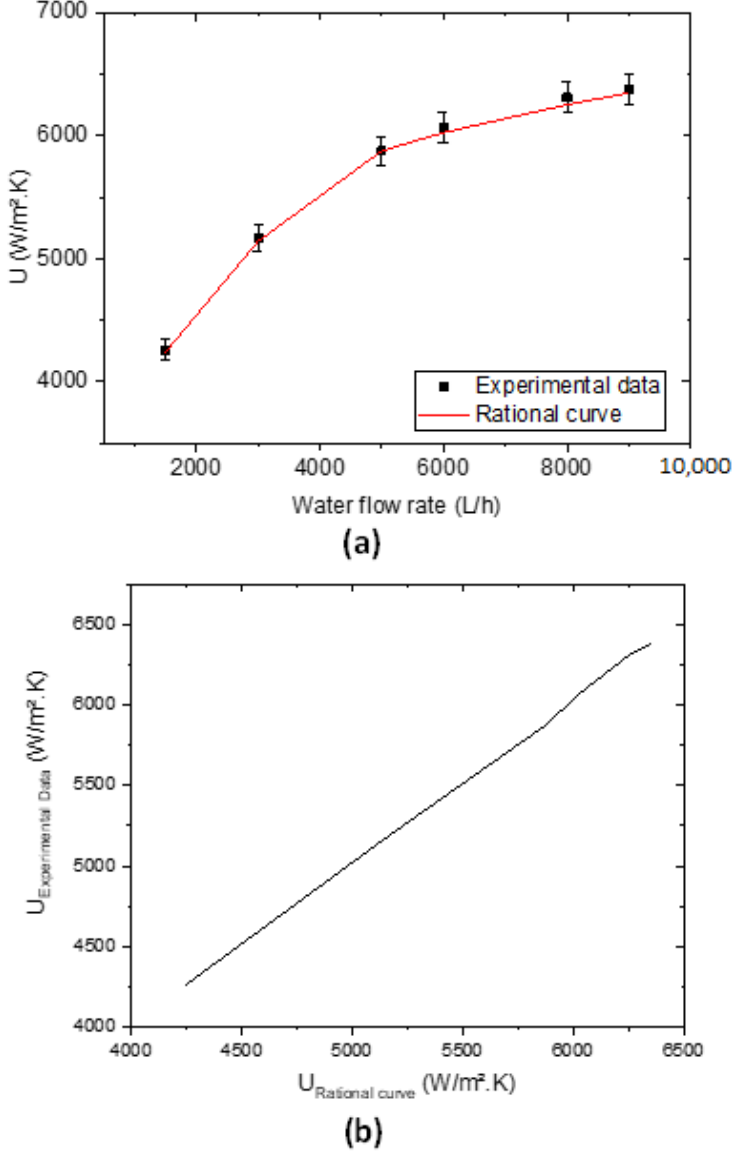
Figure 9. Variation versus water flow rate of ( a ) experimental and rational overall heat transfer coefficients and ( b ) relative error of extrapolation.